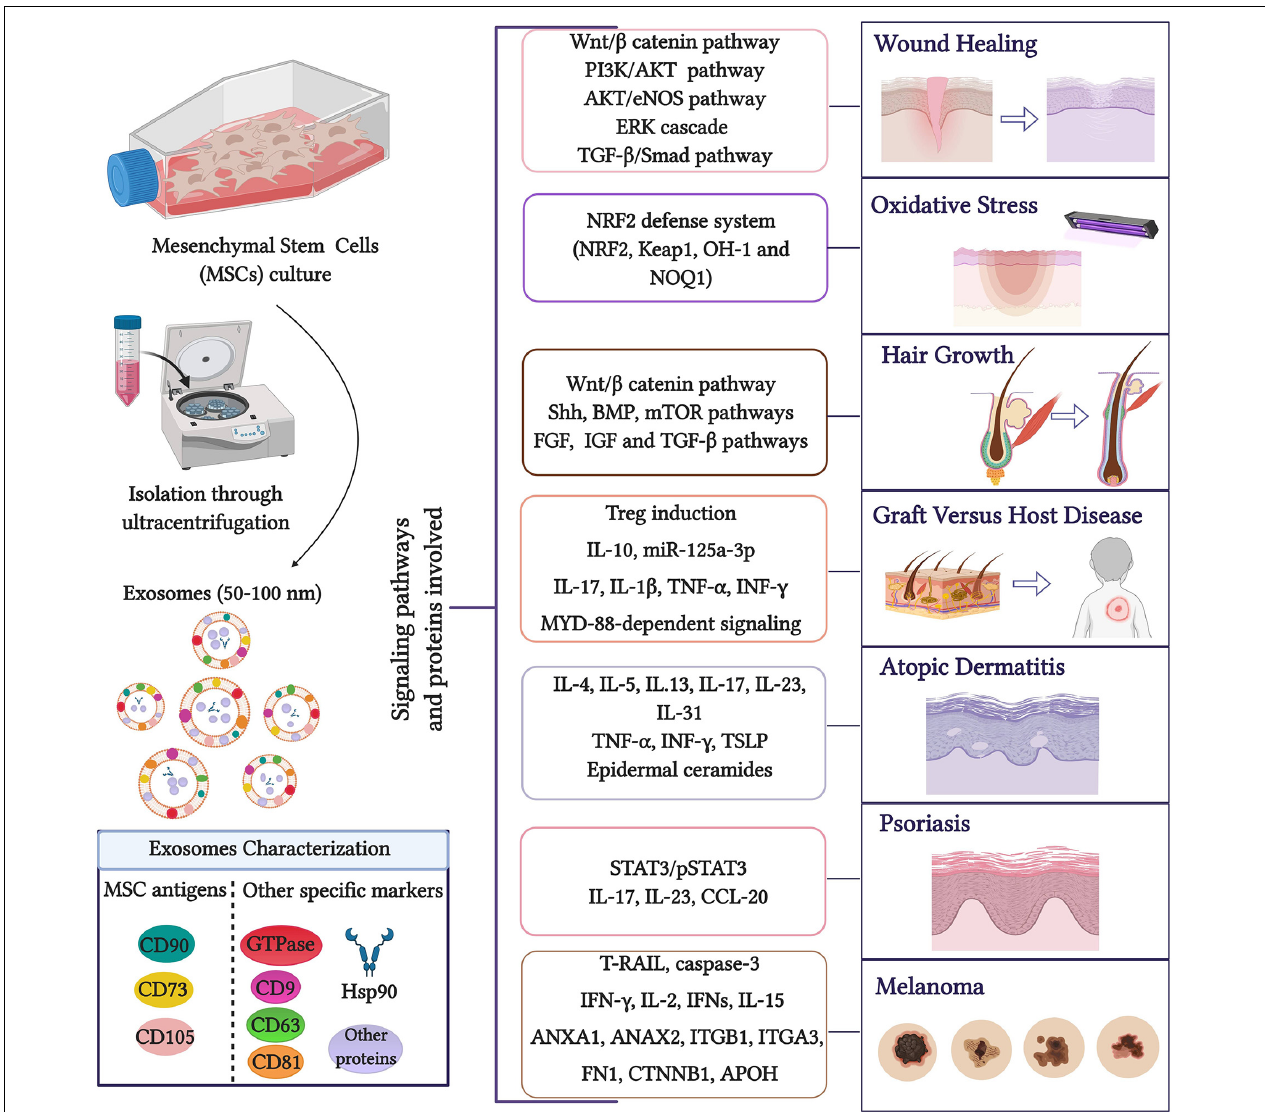
FIGURE 1 | Role of MSC exosomes in dermatology. Exosomes are widely isolated through MSC culture media ultracentrifugation (Gardiner et al., 2016) although other isolation methods such as commercial kits, polyethylene glycol/polymer-based EV enrichment and size-based fractionation have been described (Witwer et al., 2019). The presence of MSC exosome markers can be analyzed by methods including Western blotting, enzyme-linked immunosorbent assays, classical flow cytometry of bead-captured EVs, or advanced flow cytometry at the single EV level. The main signaling pathways and proteins involved in the role of MSC exosomes are highlighted. Created with